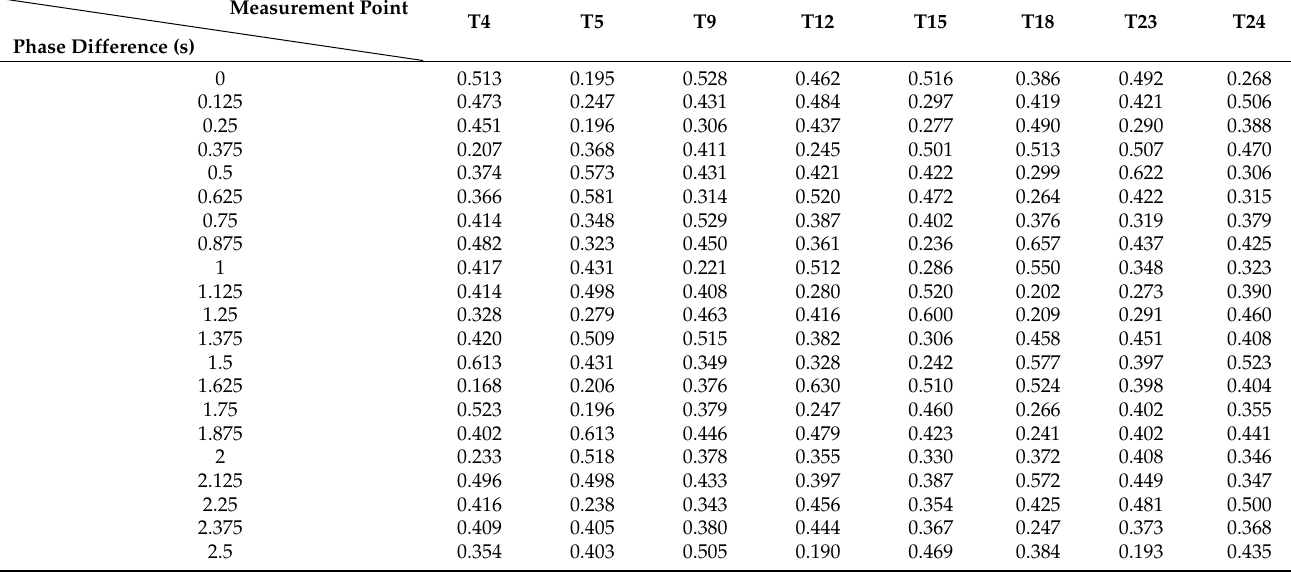
Table 2. The correlation coefficient of different measurement points in different phase differences.